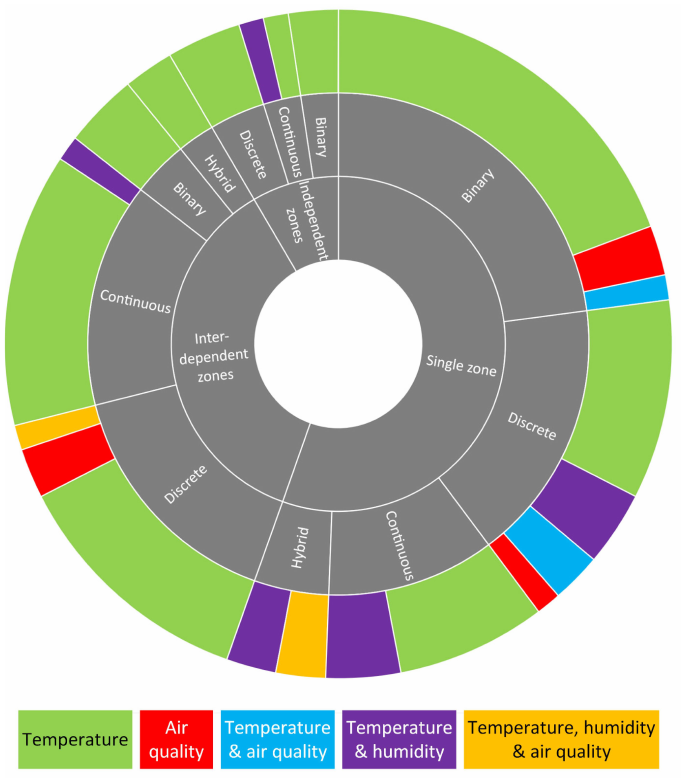
Figure 4. Sunburst chart of the 3-tier categorization of the